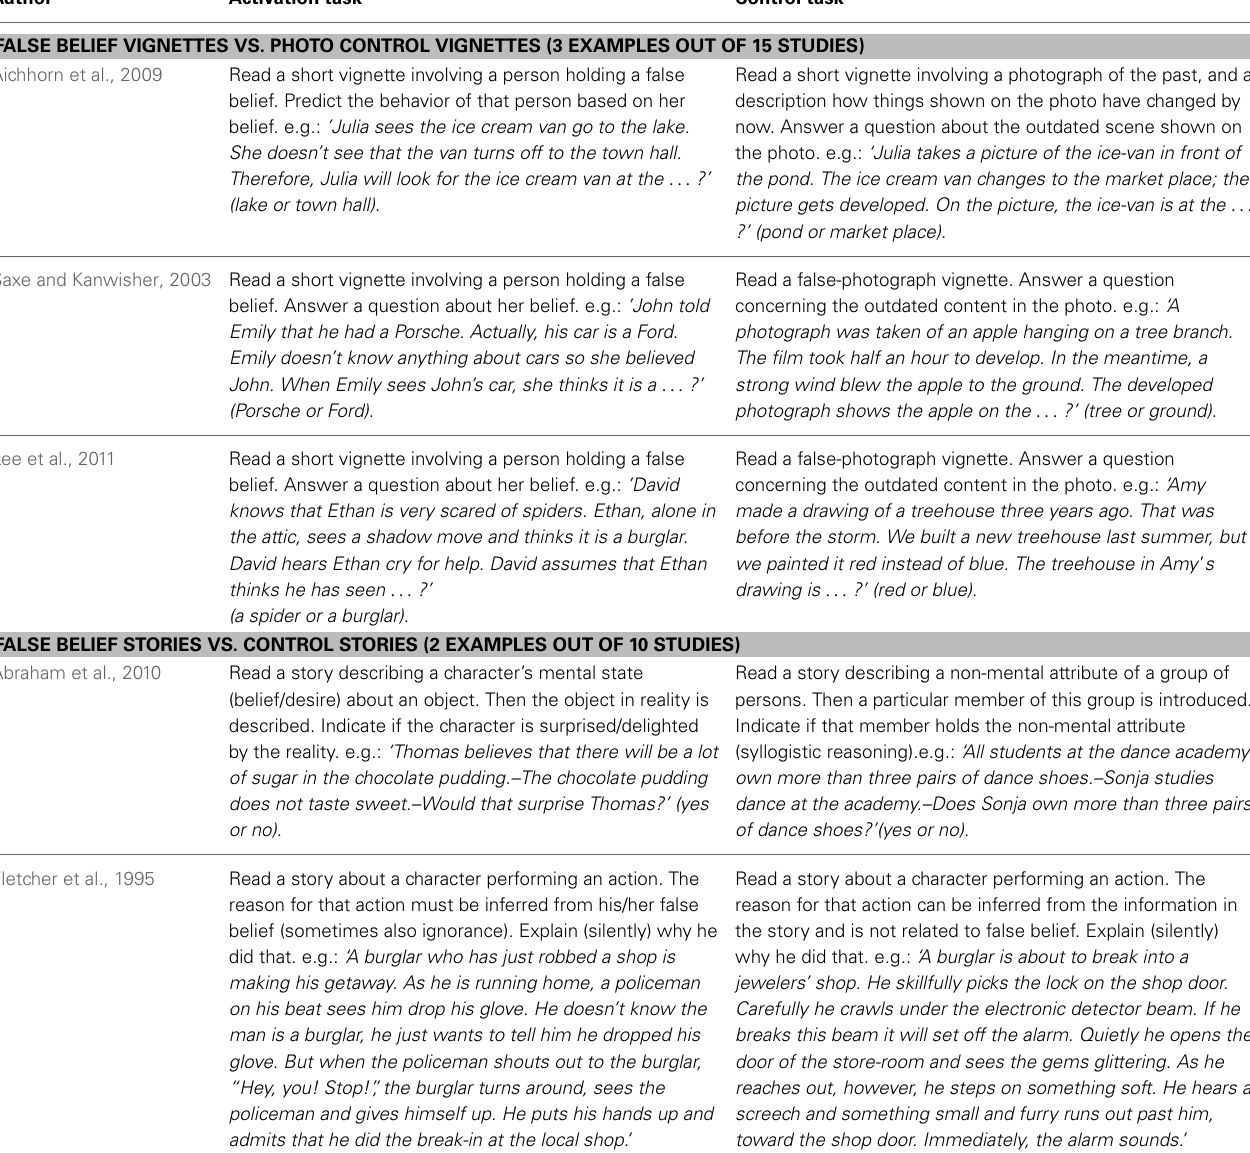
Table 1 | Examples for false belief reasoning